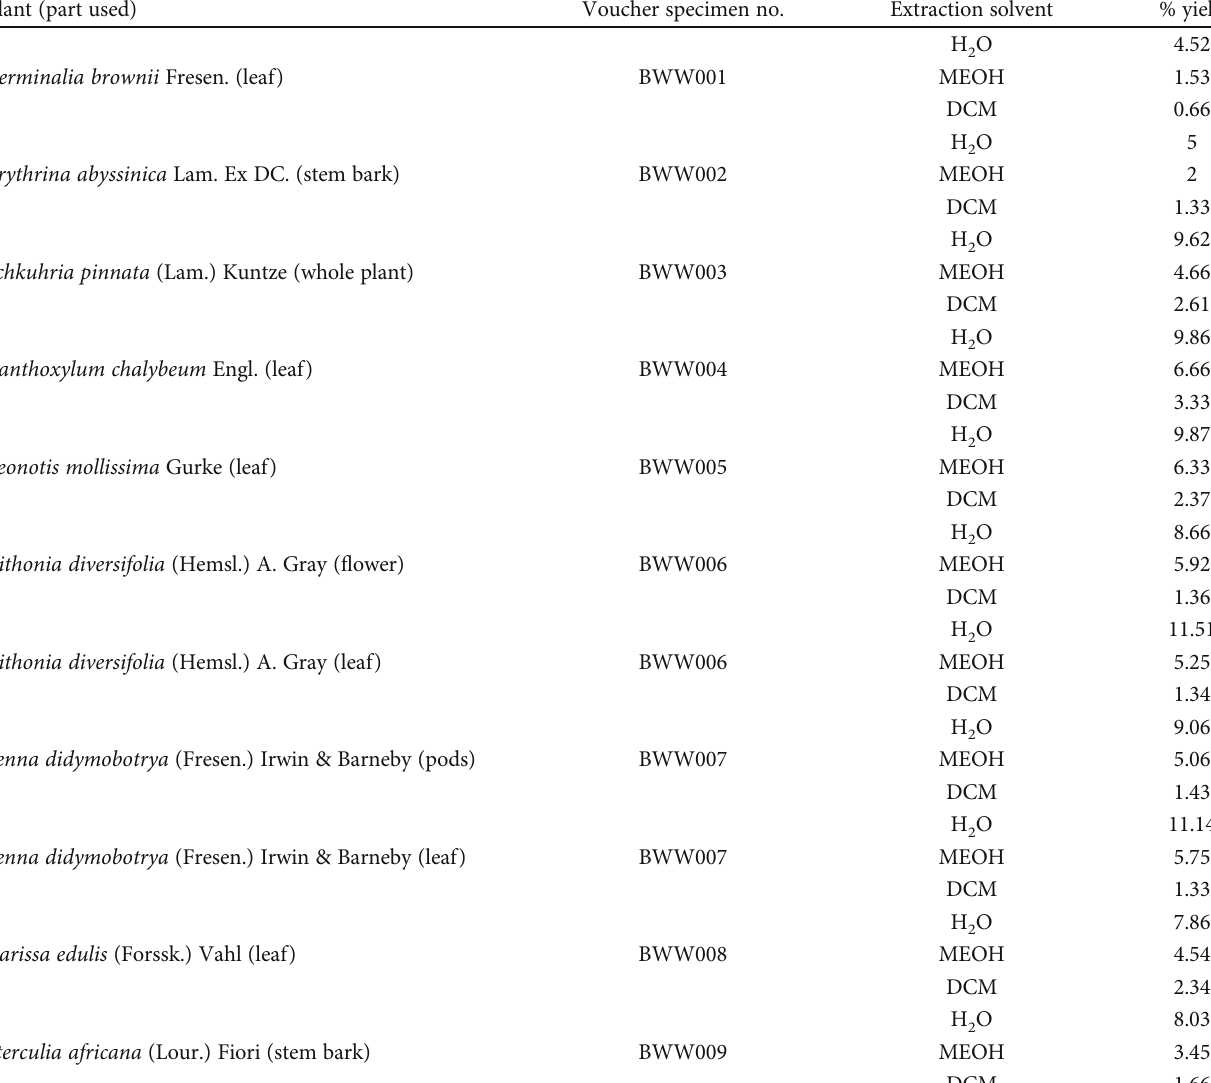
Table 1: Percentage yields of studied plant extracts. Plant (part used) Voucher specimen